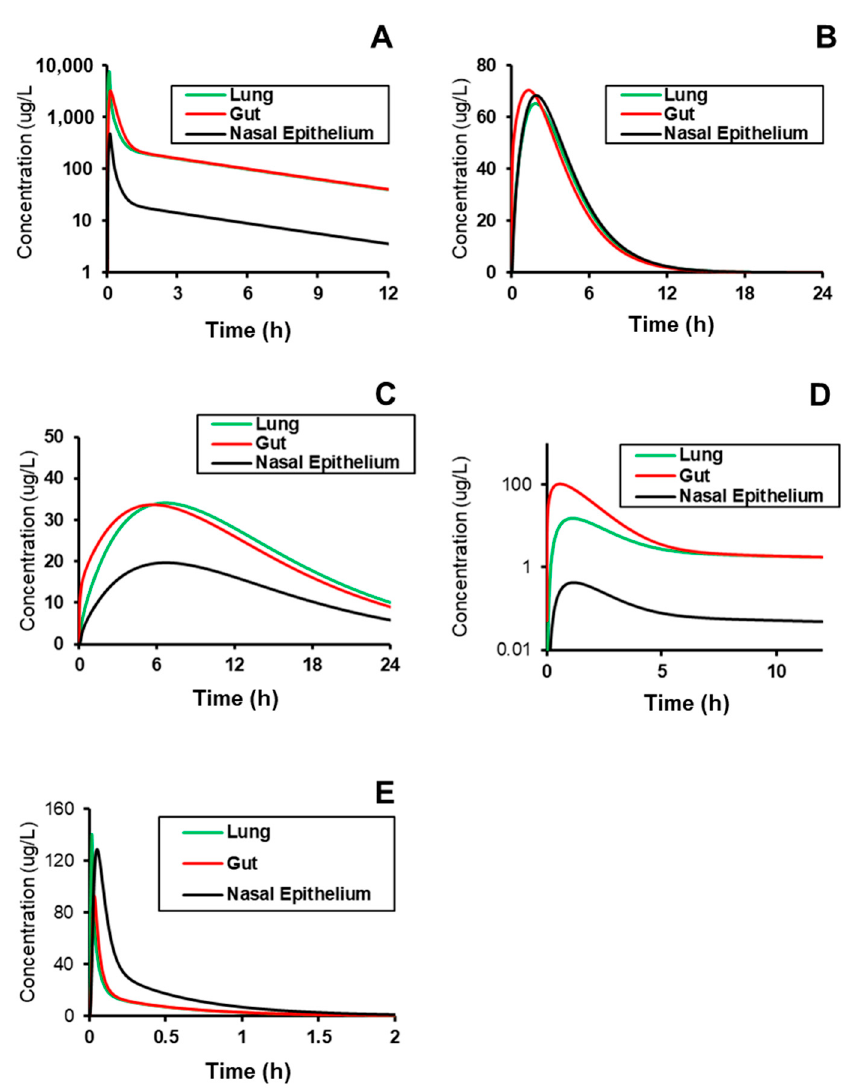
Figure 4. Prediction of the site-specific distribution of ( A ) Verapamil (i.v.), ( B ) Spirapril (p.o.), ( C ) Lisinopril (p.o.), ( D ) Lacidipine (p.o.), and ( E ) Captopril (i.v.) to tissues implicated in COVID-19 replication and pathogenesis. Subject conditions are described in Table 3. Table 5. PK metrics calculated from simulations of drug distribution to ACE-expressing organs and tissues. Metrics